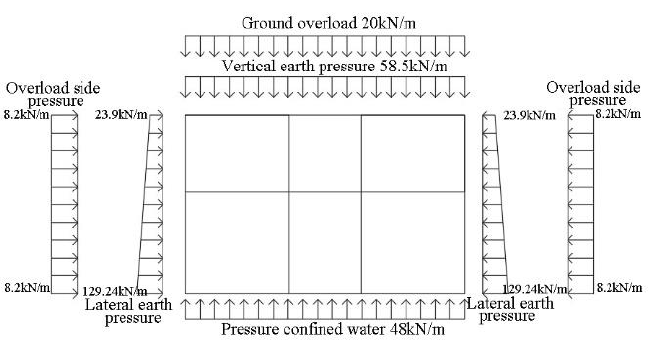
Figure 17. Load calculation diagram.